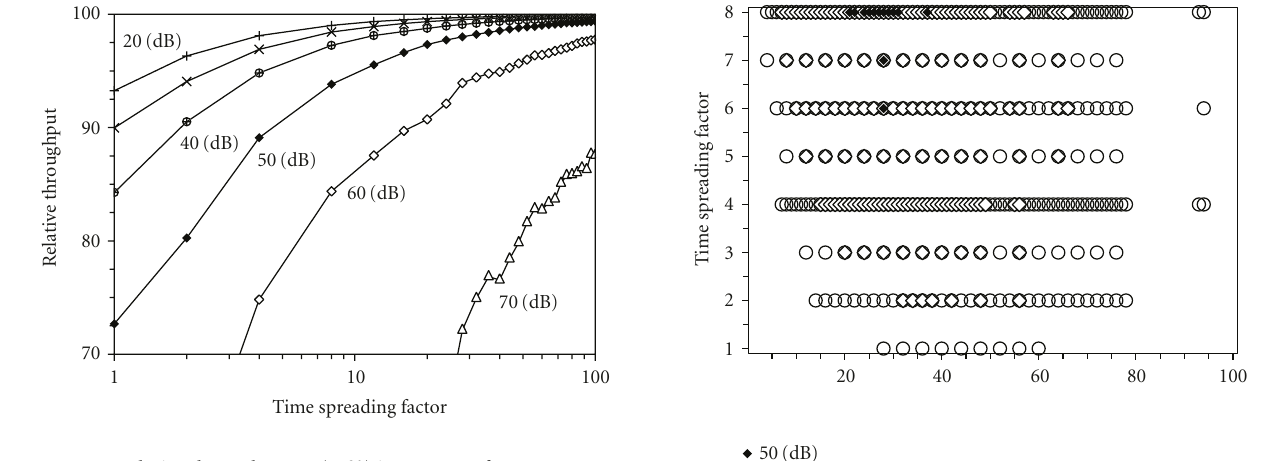
Figure 8: Relative throughput R/ ( L t R ) in percent of SS-OFDM sys- tem with L f = 1 versus code length, over PLC channel no. 1 and for six channel attenuations { 20,30,40,50,60,70 } dB.